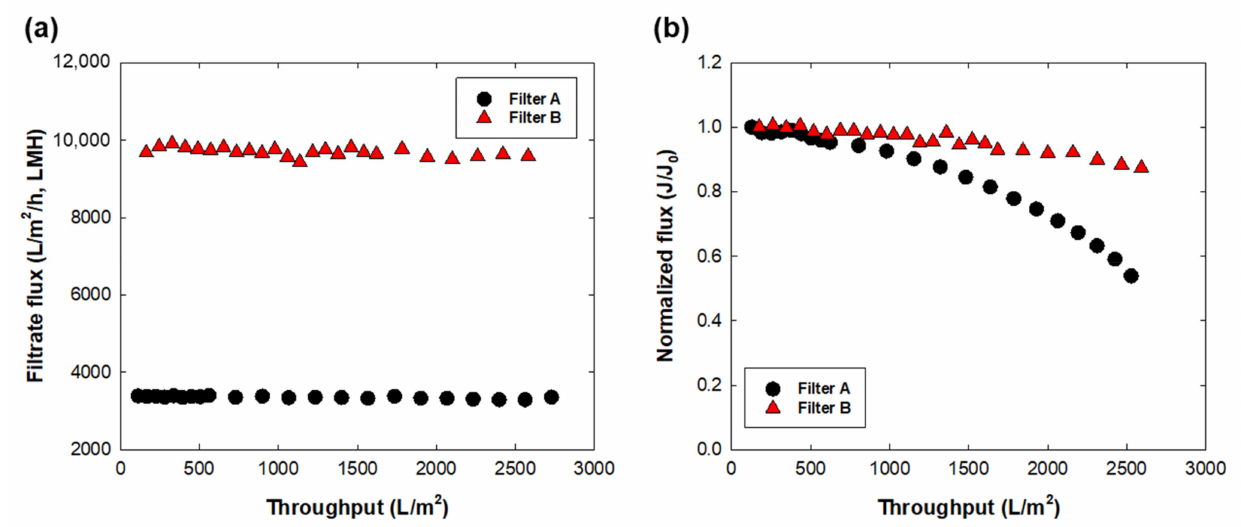
Figure 4. Filtrate flux behavior for ( a ) PBS buffer and ( b ) LB broth with filters A and B. The initial flux (J 0 ) was 3400 LMH for filter A and 9700 LMH for filter